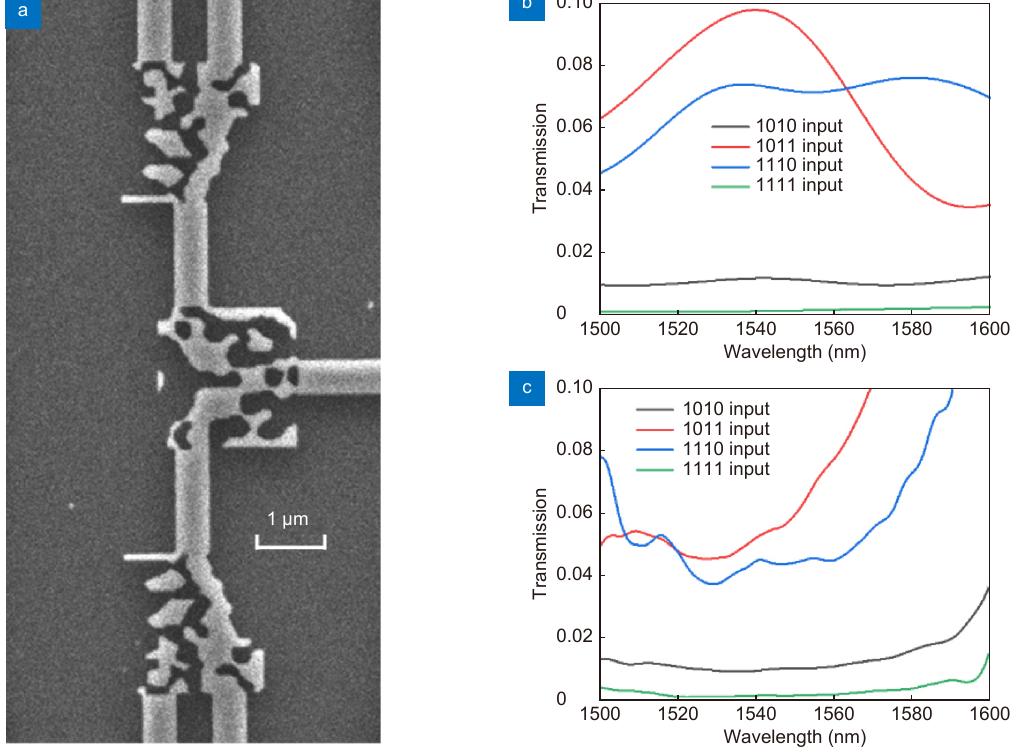
Fig. 7 | Characterization of the all-optical integrated circuit. ( a ) Scanning electron microscopy (SEM) image of the all-optical integrated circuit. The size of the optimized area was 2.5 μm×7 μm. ( b ) Simulation results of the transmission of the all-optical integrated circuit. ( c ) Experiment results of the normalized transmission of the all-optical integrated